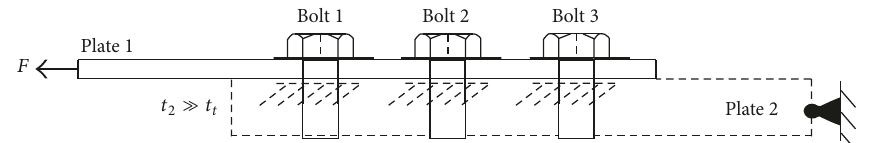
Figure 26: Effect of the 𝑡 2 /𝑡 1 ratio more than 1 ( ≫ 1) to the steel bolts.